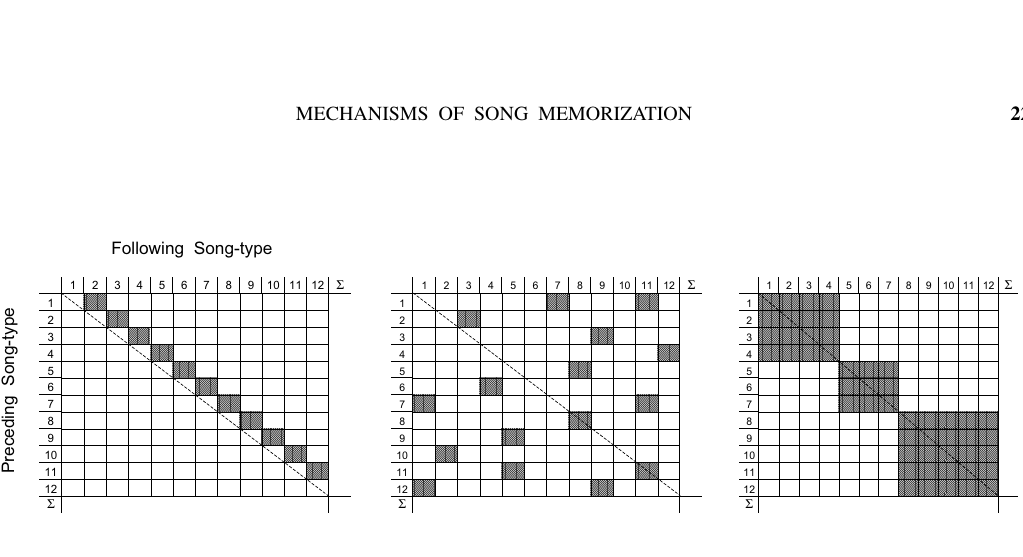
Fig. 2 – Schematic illustration of three possible relationships between the serial succession of master song-types and that of imitations developed by the subjects. The succession of master song-types in a given string is represented in the row and column categories of the transition matrices. Sequential transitions between imitations from that string are illustrated by hatched areas in the cells of the matrix body. Left: the sequential succession of imitations matches that of master song-types: all transitions are in the cells next to the major diagonal. Middle: transitions between imitations are random with respect to the sequencing of the master song-types. Right: the sequential succession of master song-types is reflected in the subjects singing. Transitions between imitations are centered around the major diagonal, but this holds only for a limited number of imitations developed from successively presented master song-types. Imitations which form a cluster of transitions are the constituents of a given ‘song-type package’.